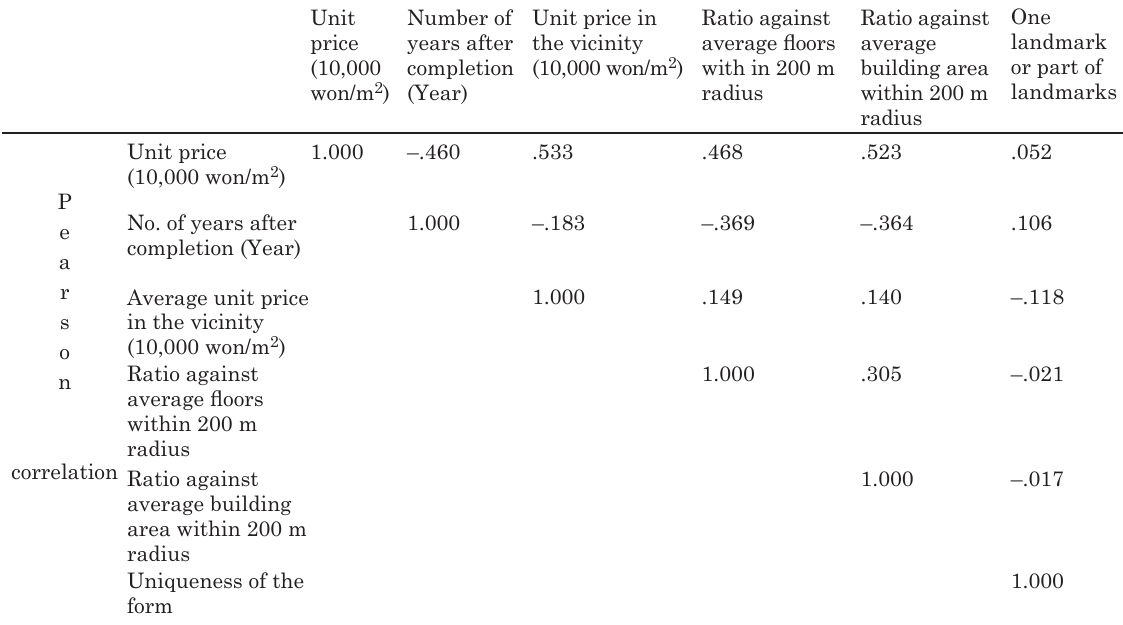
table 8. An analysis of correlation coefficients of explanatory variables that are set again